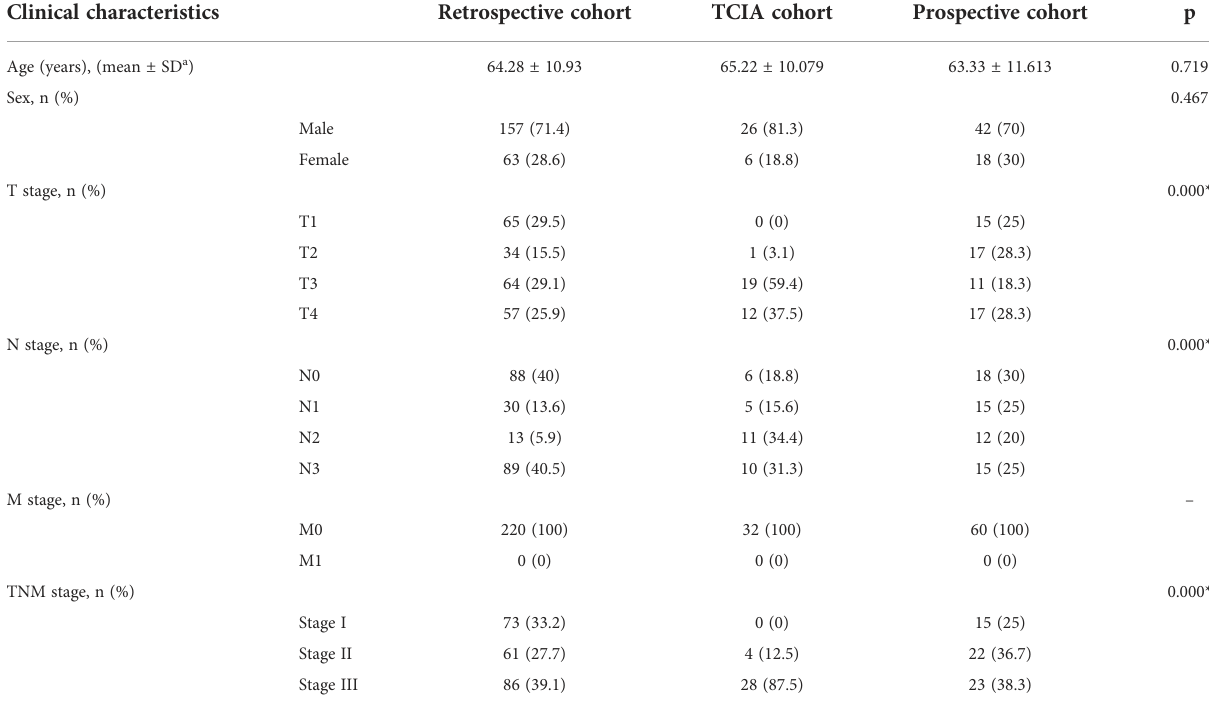
TABLE 1 Patient characteristics in each cohort (DetectionNet). Clinical